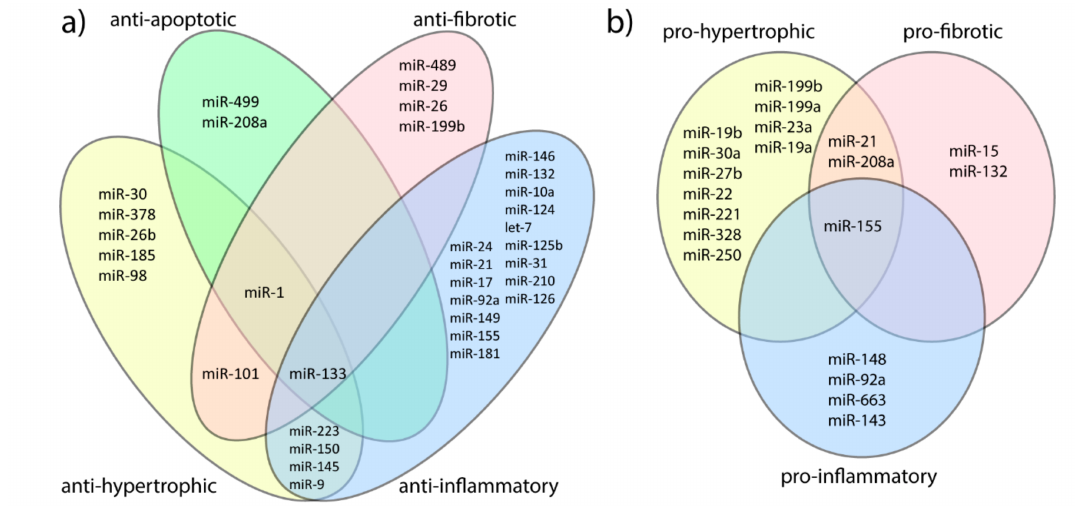
Figure 1. The potential role of microRNAs in cardiac remodeling. ( a ) MicroRNAs associated with ibeneficial response to endurance exercise. ( b ) MicroRNAs associated with pro-inflammatory, pro-fibrotic and pro-hypertrophic processes in cardiac remodeling. miR,